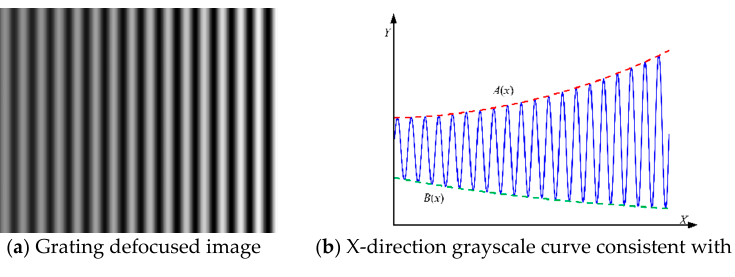
Figure 5. Rotation mask.